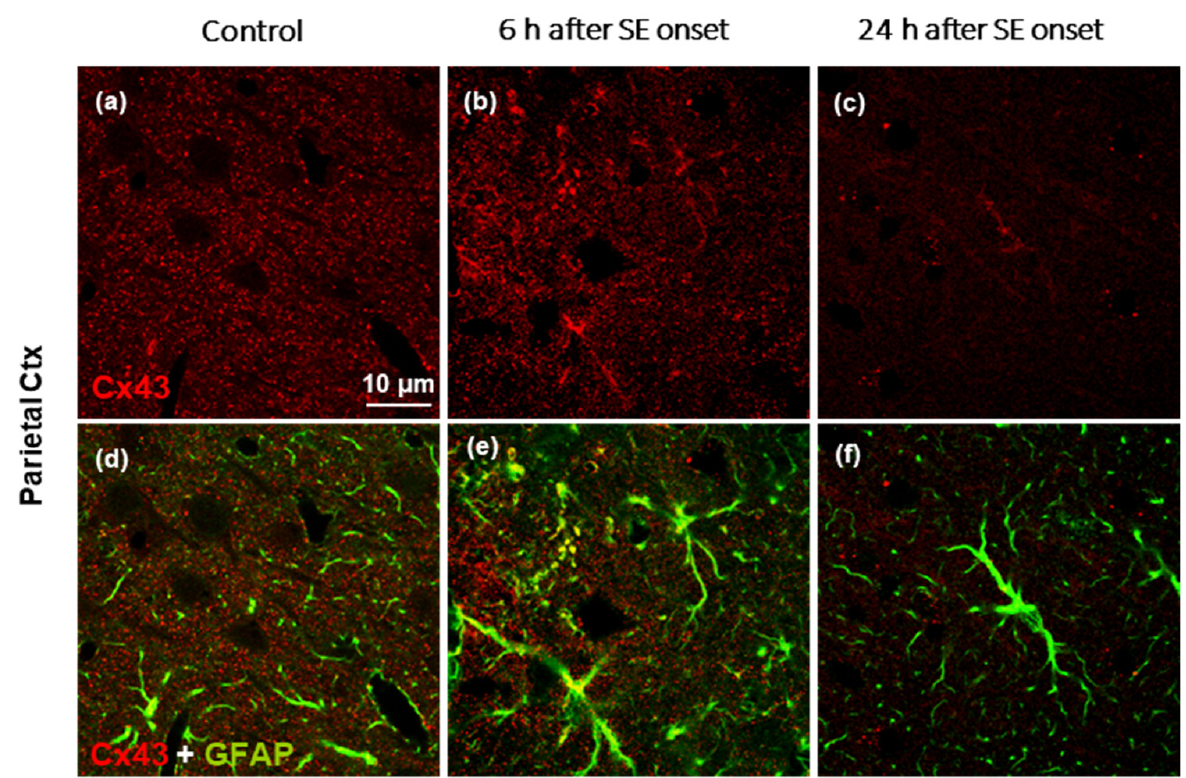
Figure 3. Immunolabeling of Cx43 revealed as punctate staining of the neuropil ( a – c ) and simultaneous visualization (merging) of Cx43 and glial fibrillary acidic protein (GFAP) immunopositivity of astrocytes ( d – f ) in the parietal cortex under confocal microscopy in the control animals ( a,d ), and at 6 h ( b , e ) and 24 h ( c , f ) after the onset of pilocarpine-induced seizures lasting 3 h. Note the downregulation of Cx43 at 24 h.